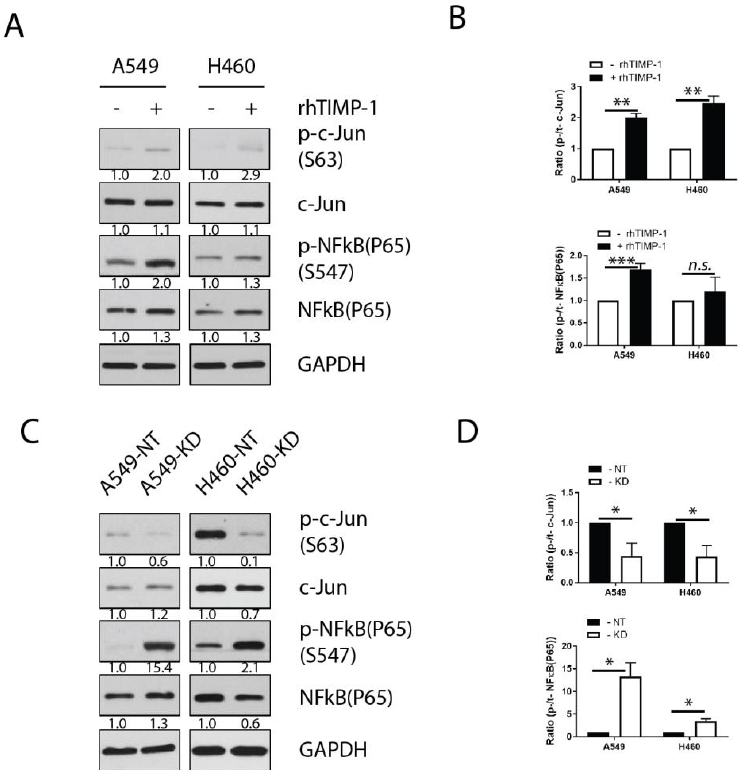
Figure 4. AP-1 transcriptional factor participates in TIMP-1-regulated IL-6 expression. ( A ) A549 and H460 cells were cultured in complete medium and treated with exogenous rhTIMP-1 for one hour. Whole-cell lysates were analyzed for transcription signaling, as indicated by immunoblotting. ( B ) The band intensity of relevant protein (NF κ B (P65) and AP-1 (c-Jun)) was normalized to that of the reference gene by the ImageJ program. Relative ratios of phosphorylated signal to total signal are presented. ( C ) A549- or H460-derived NT and KD clones were seeded into flasks at 70–80% confluency and grown in complete medium with 10% FBS. Cells were rinsed once and replaced with warm FBS-free medium for another six hours prior to lysis. Whole-cell lysates were analyzed for transcription signaling as indicated by immunoblotting. ( D ) The band intensity of relevant proteins was normalized to that of the reference gene by the ImageJ program. Relative ratios of phosphorylated signal to total signal are shown. Statistical significance is denoted as follows: * p < 0.05; ** p < 0.01; *** p < 0.001